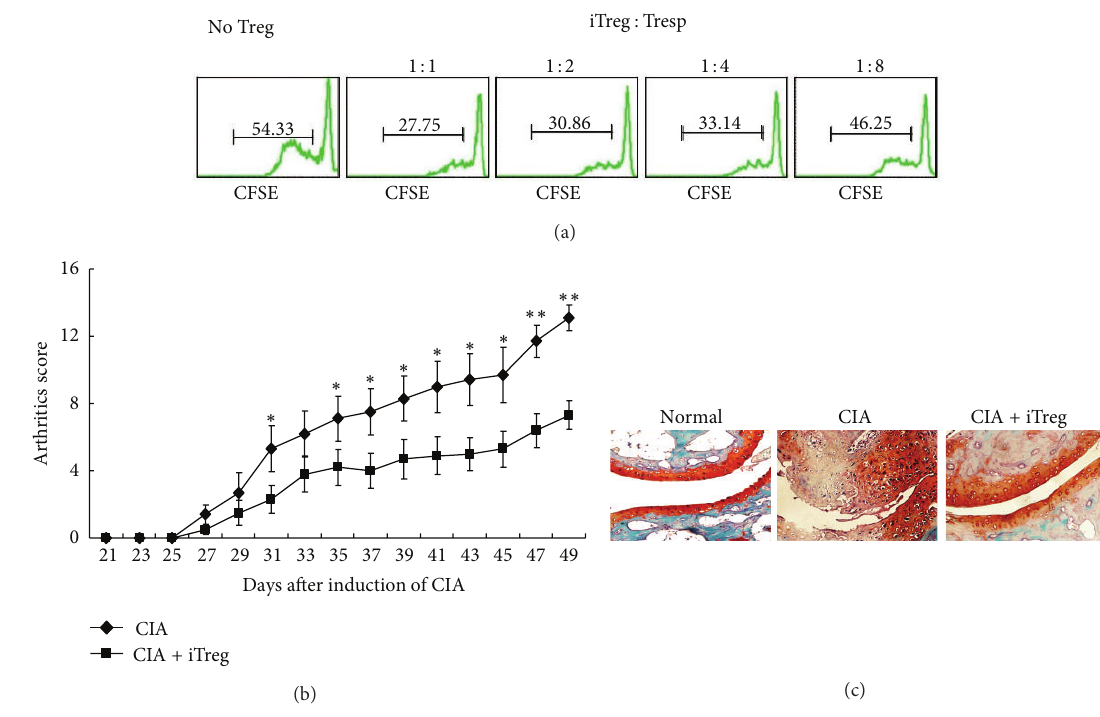
Figure 1: The adoptive transfer of iTregs suppressed the development of CIA. (a) The capacity of iTregs to inhibit CD4 + T cell proliferation was assessed through CFSE staining. Different doses of iTregs were added to the proliferation assay, and the progressive dilution of CFSE in responder cells was used as a readout of proliferation. (b) CIA mice subjected to the adoptive transfer of iTregs or not were scored for clinical signs of arthritis in the limb joints through macroscopic examination three times a week and were sacrificed 49 days after the first immunization with CII. The arthritic scores in each group ( 𝑛 = 10 ) were expressed as the means ± SEM. ∗ 𝑃 < 0.05 , ∗∗ 𝑃 < 0.01 compared with CIA mice using unpaired t -tests. (c) Hind paw specimens from recipient mice treated with or without iTregs were collected 3 weeks after the onset of CIA and were stained with Safranin O (showing cartilage